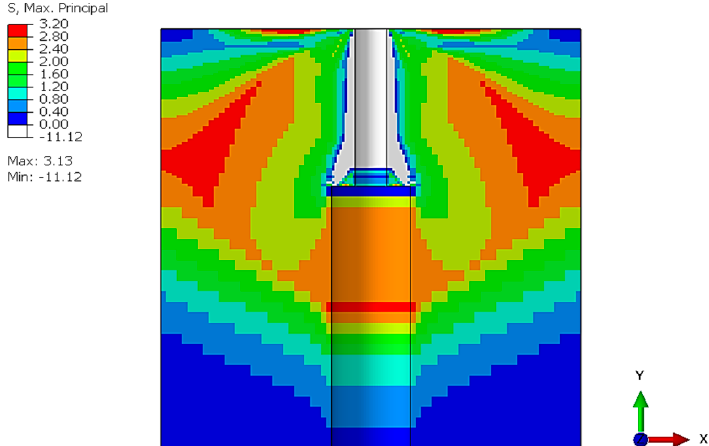
Figure 20. Map of maximum principal stresses for the POT-12 series.